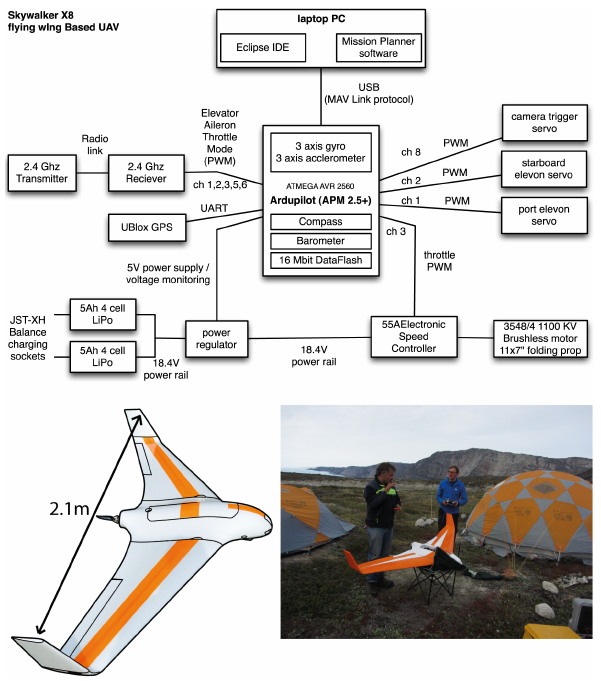
Figure 2. Flowchart of the control set-up and picture of the UAV at base camp with the relative